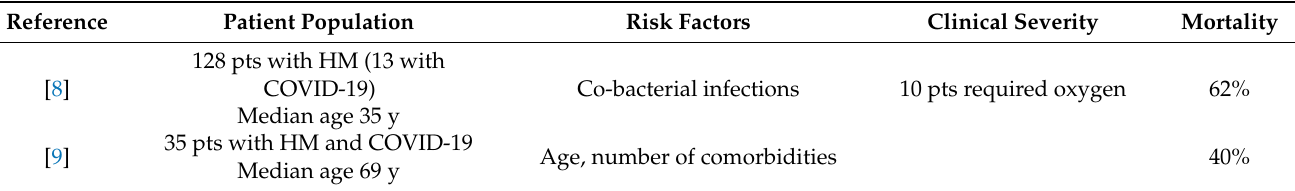
Table 1. COVID-19 in patients with hematologic malignancies